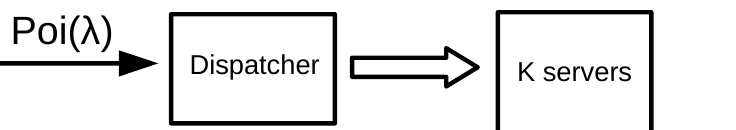
Figure 4. A decentralized system with 2 groups. Each dispatchers receives λ /2 traffic and sends it to K /2